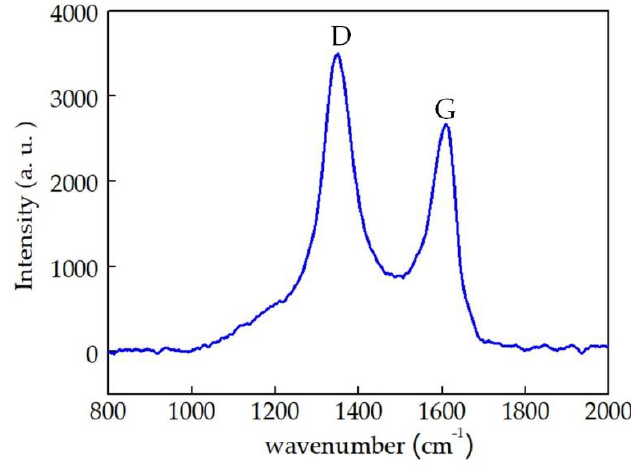
Figure 9. Raman spectra of the SiAlCO ceramic sample.